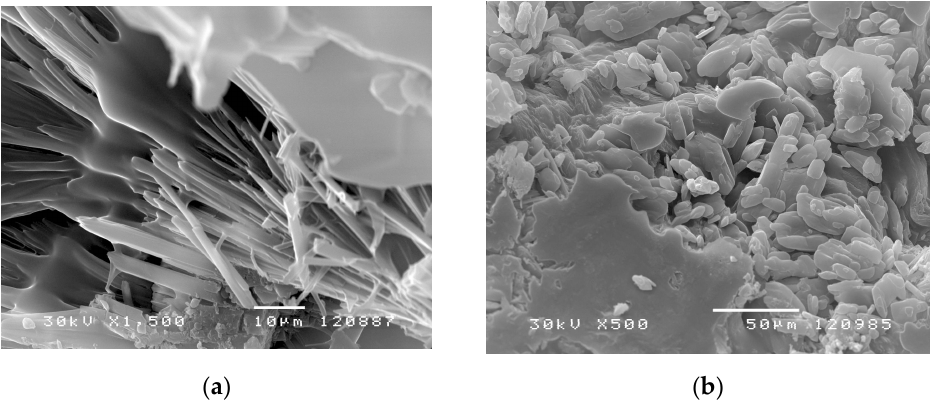
Figure 6. SEM micrographs of p( N iPAm- co -HPMet) sample with 1.0 mol% of EGDM: ( a ) in xerogel state (magnification 1500×, scale bar 10 µm) and ( b ) in hydrogel state 500× (magnification 500×, scale bar 50 µm).